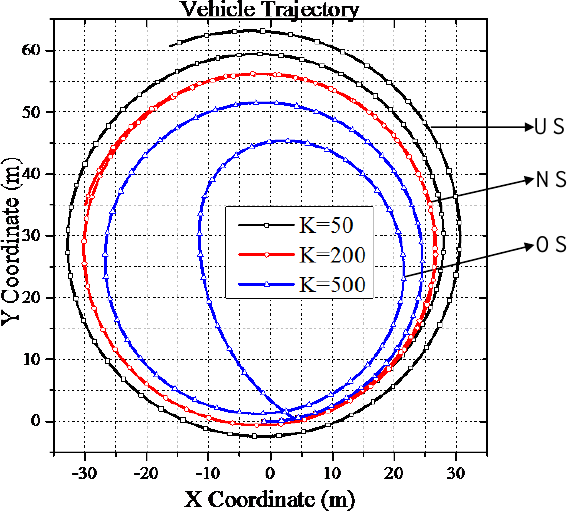
Figure 7. EDS test under different K gain.